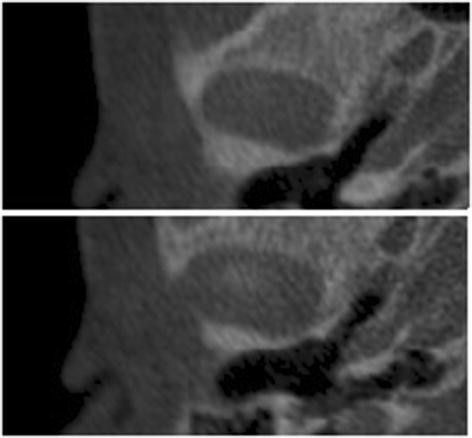
The superior limit of condylar head is selected when the first white area appears in the upper articular region, while scrolling the images from the upper to the lower regions of the joint space.